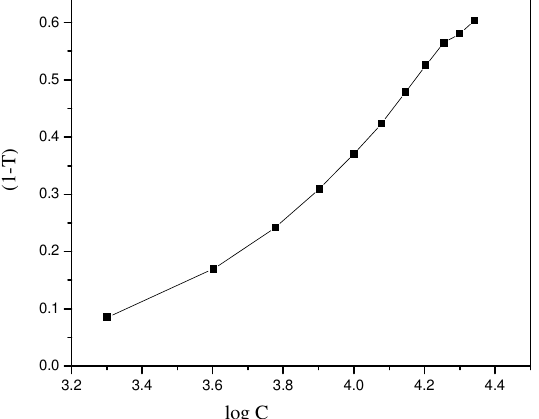
Figure 4. Ringbom’s plot of Pd(II) – 3,4-DHBINH complex ; Pd(II) :2000-24000 µ g L −1 ; 3,4 –DHBINH: 1.0 mL of 1.0×10 −3 M; pH: 3.0; λ